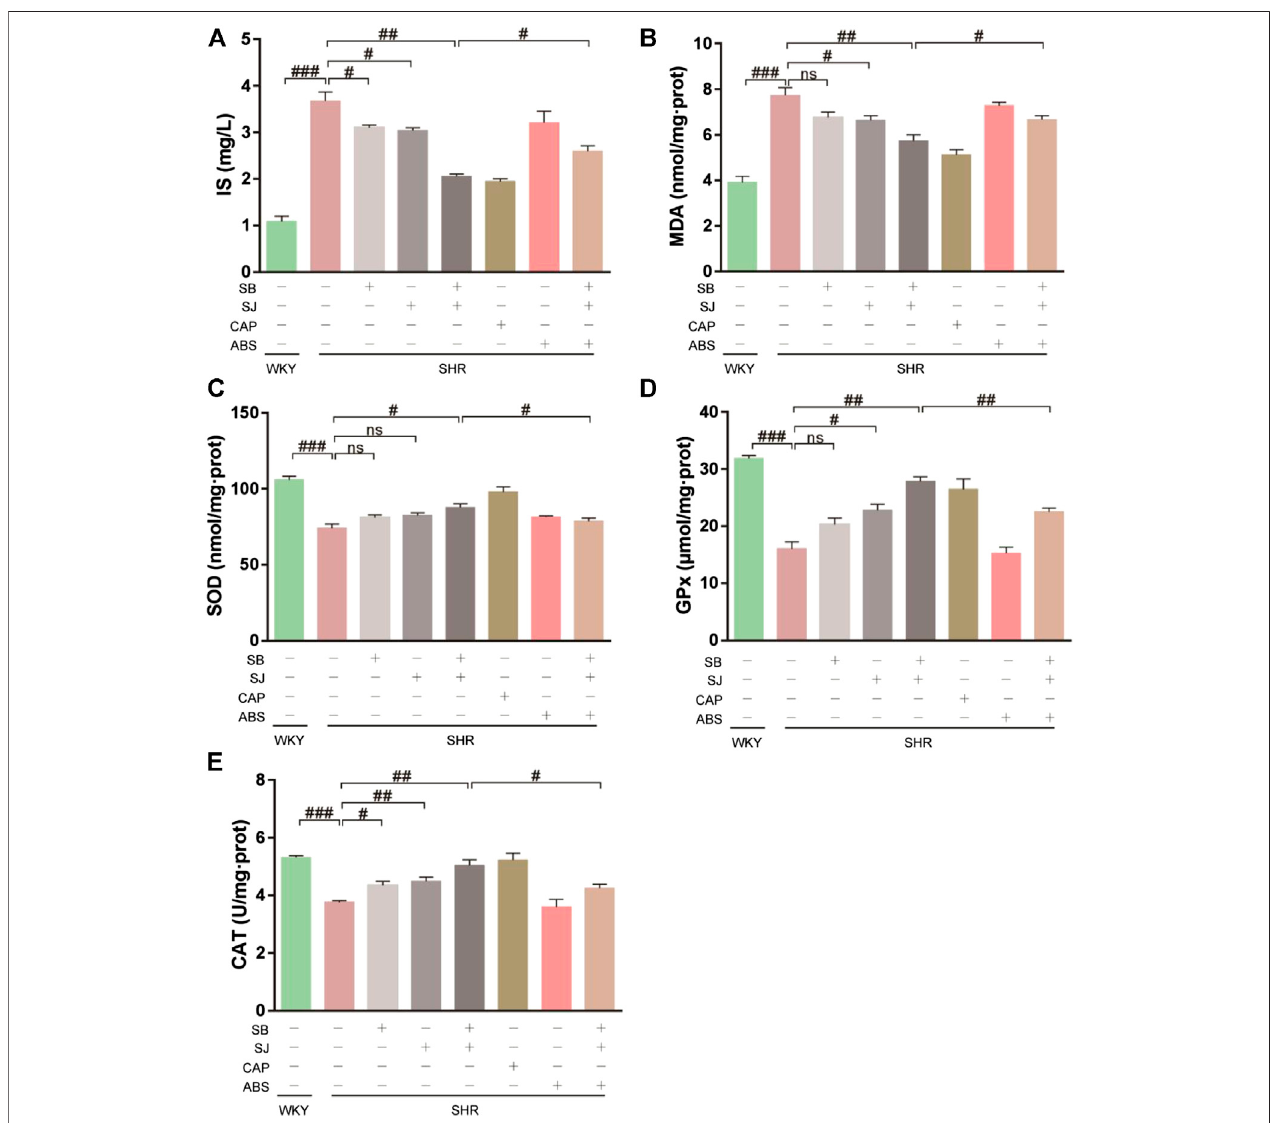
FIGURE6| InhibitionofserumISandoxidativestressinkidneysbythecombinationofSBandSJinSHR. (A) ISinserum. (B – E) ThelevelsofMDA,SOD,GPx,and CAT in kidneys. Data are presented as the mean ± SD. ### p < 0.001. ## p < 0.01. # p < 0.05.